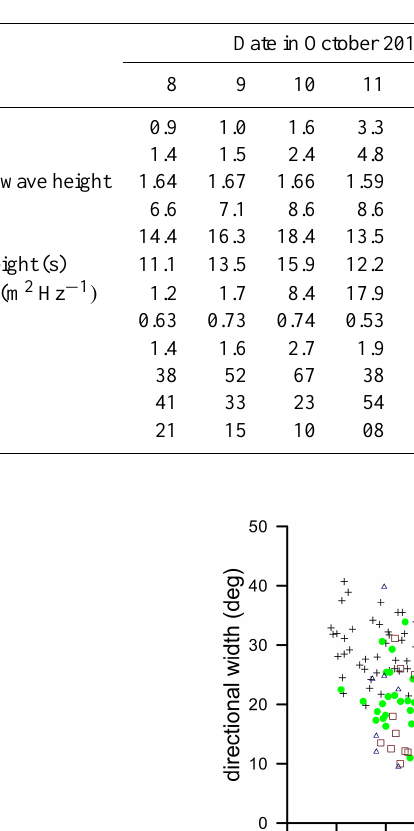
Table 2. Daily mean wave parameters during 8–13 October 2013.